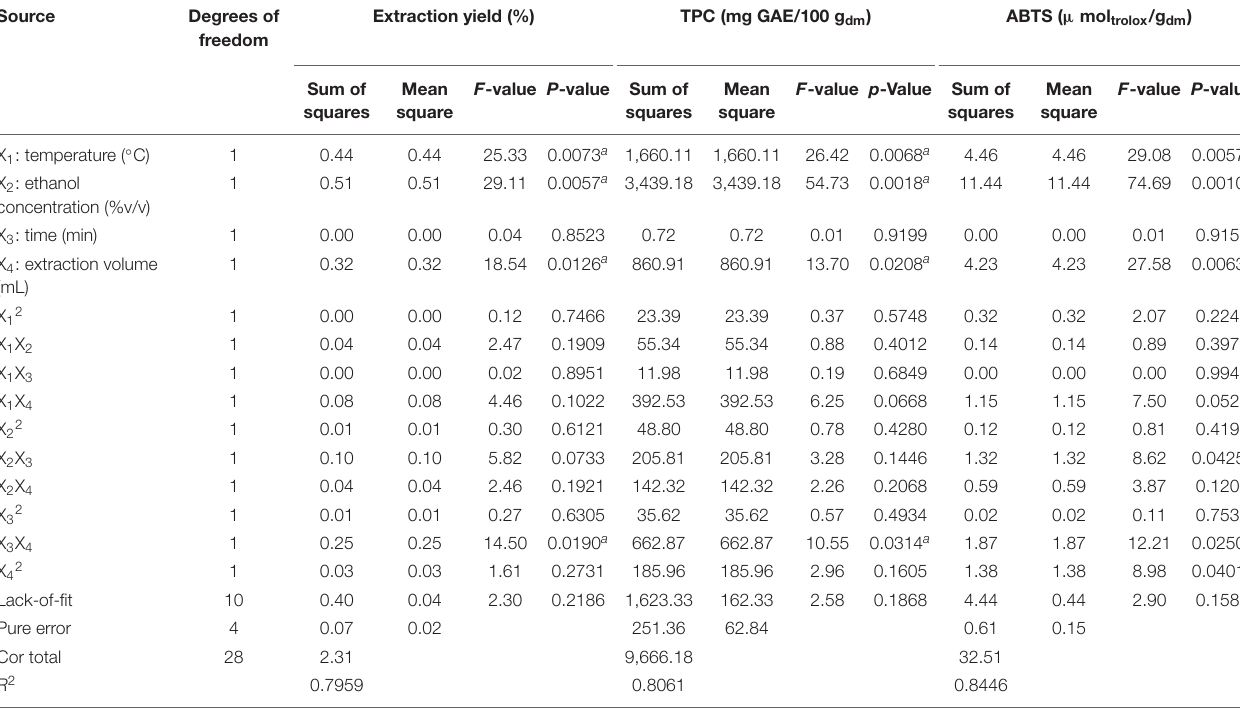
TABLE 4 | Analysis of variance obtained for response surface quadratic models in DP extraction.